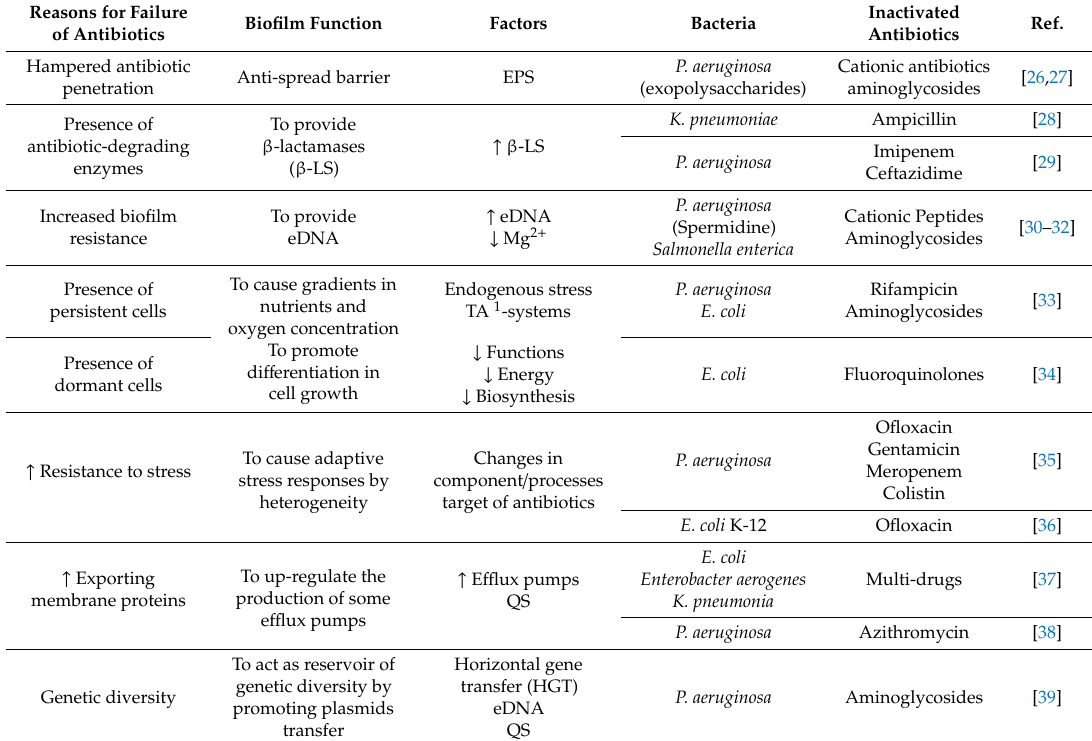
Table 1. Bacteria biofilm contribution in the antibiotic’s inactivation and antibiotic treatment failure. Reasons for Failure of